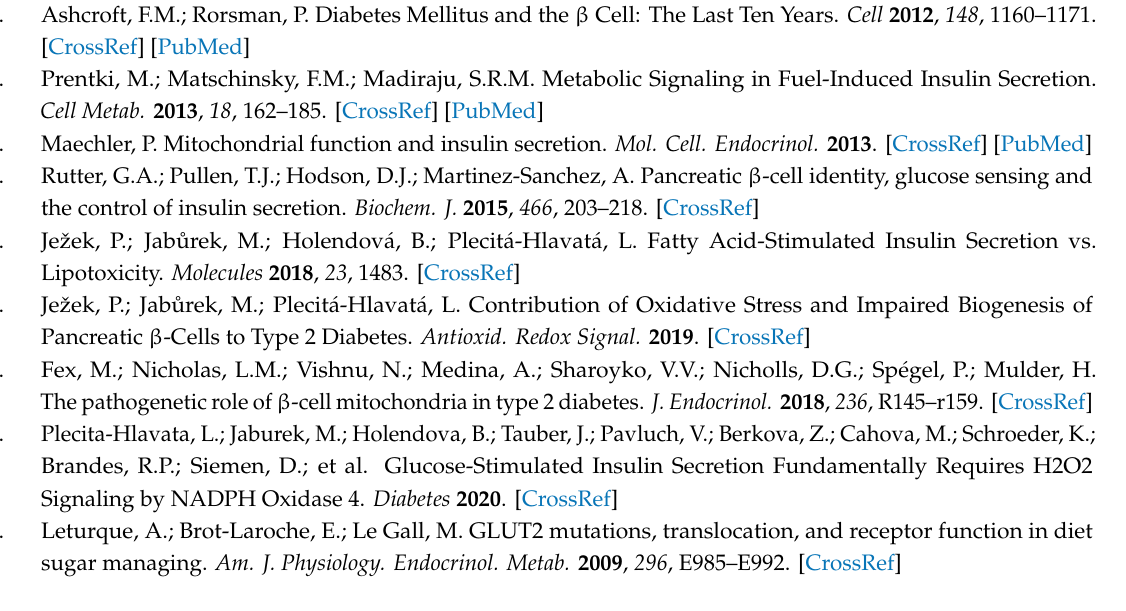
Figure S1: Typical changes in DAPIT mRNA levels in INS-1E cells; Figure S2: Downregulation / recovery of transcripts for F O subunits e , f and g ; Figure S3: Typical results of DAPIT silencing; Figure S4: western blots of F1 α ; Figure S5: Surplus ATP accumulation; Figure S6: Anti-DAPIT / USMG5 antibodies recognize a complex above ~75